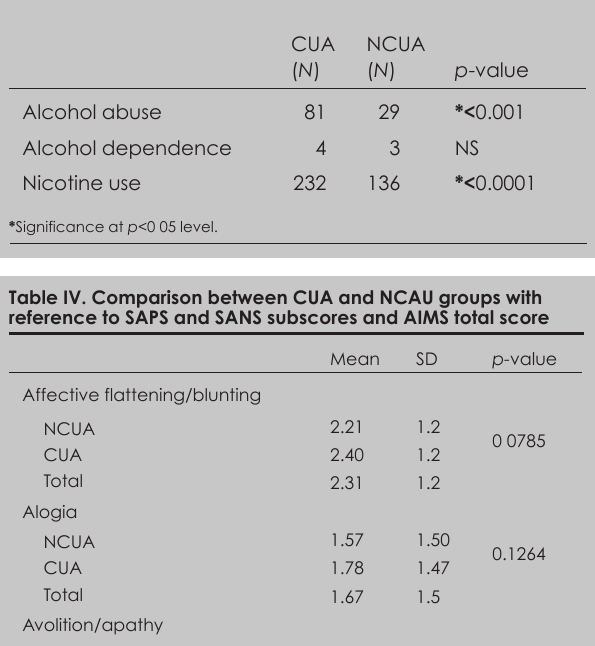
Table III. Comparison of substance variables between CUA and NCUA groups